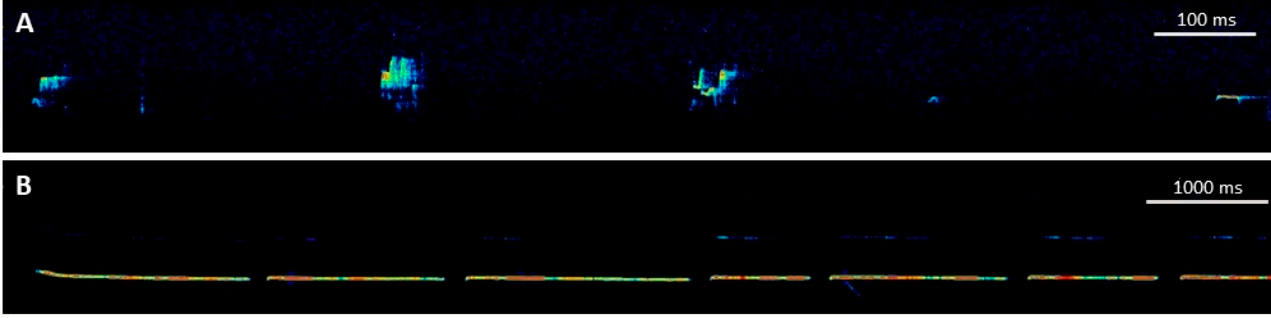
Figure 1. Exemplary spectrograms of ultrasonic vocalizations (USV) emitted by rats. ( A ) Spectrogram of 50-kHz USV serving as social contact calls. Please note the presence of different 50-kHz USV subtypes, including FLAT, STEP, TRILL, and MIXED calls. ( B ) Spectrogram of 22-kHz USV serving as alarm calls. Please note the difference in time